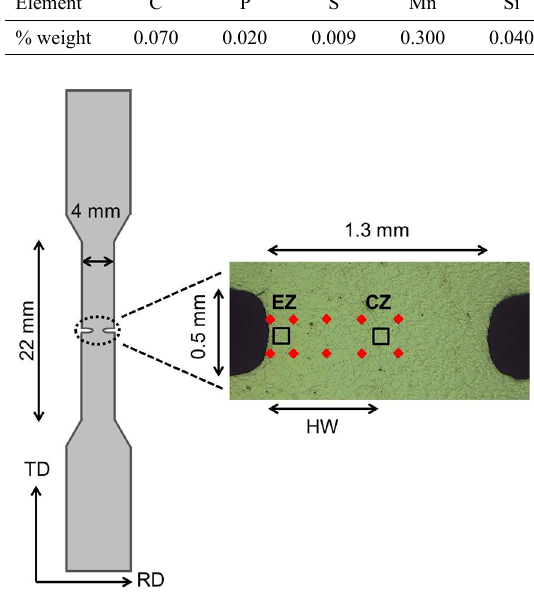
Figure 1. Sketch of the notched tensile sample indicating the different zones. HW is half the width of the notch.